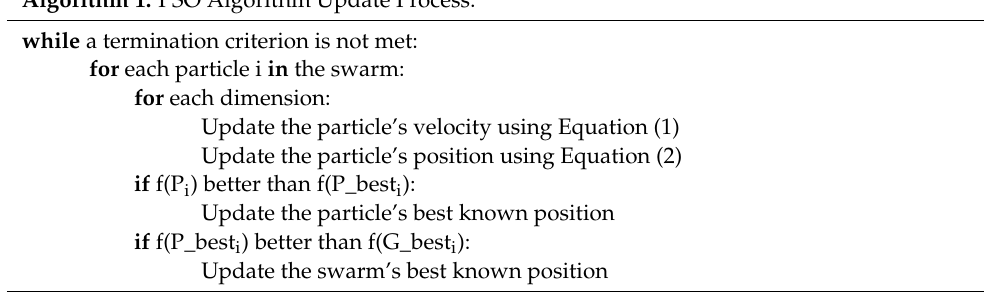
Algorithm 1 PSO Algorithm Update Process Algorithm 1. PSO Algorithm Update Process.